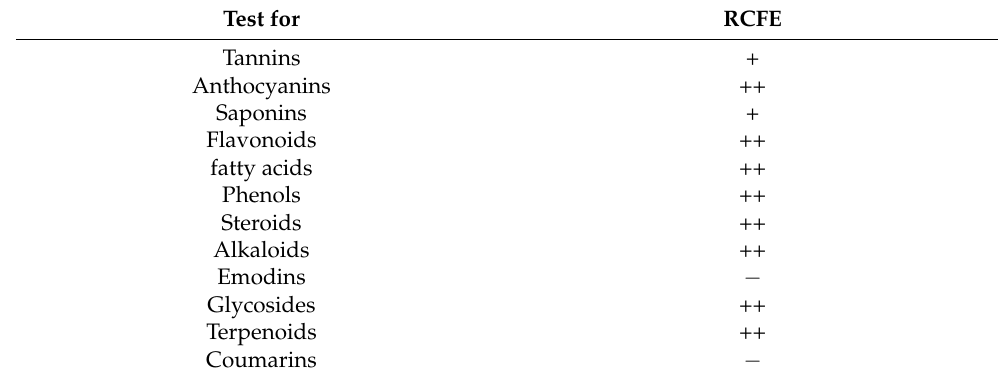
Table 1. Qualitative phytochemicals analysis of the ethanolic extract of Rosa canina fruit (RCFE). Test for RCFE Tannins + Anthocyanins ++ Saponins + Flavonoids ++ fatty acids ++ Phenols ++ Steroids ++ Alkaloids ++ Emodins − Glycosides ++ Terpenoids ++ Coumarins −